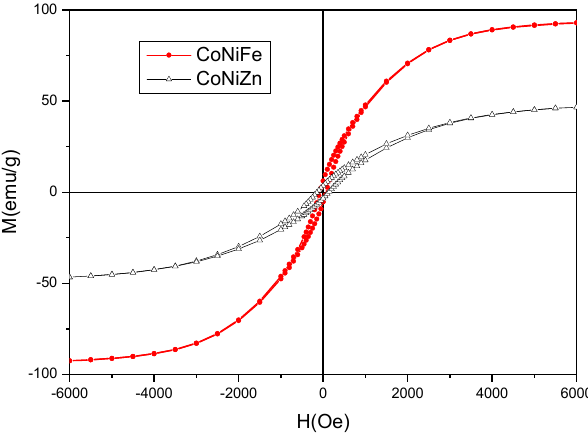
Figure 3. The magnetic hysteresis loops of the prepared samples.